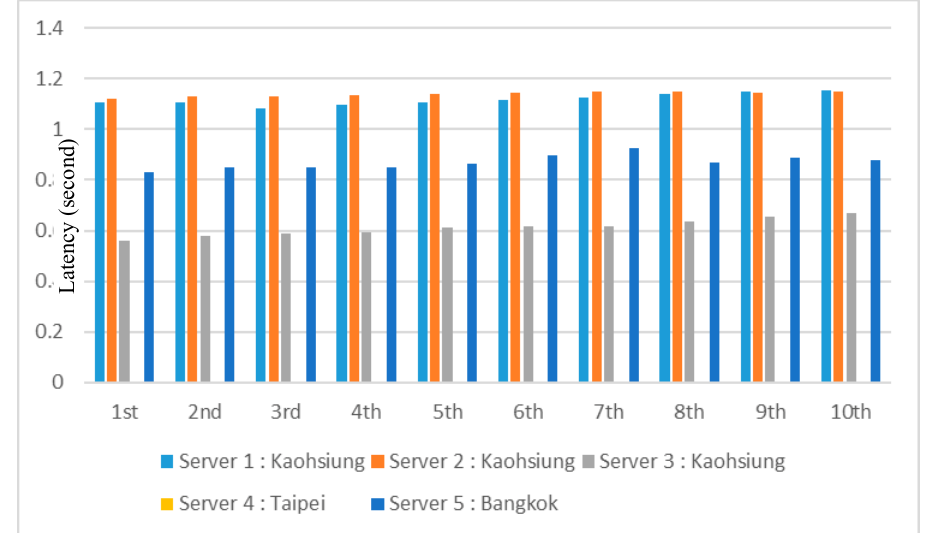
Figure 21. Latency average of five different servers using 4G cellular communication; latency time in seconds on Y axis, test number on X axis.